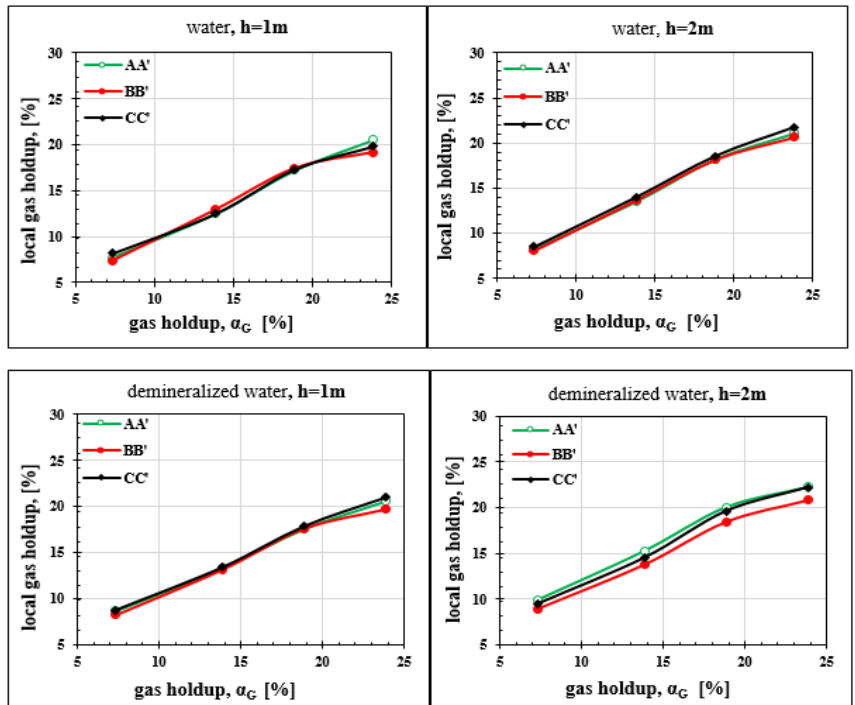
Figure 14. Relationship between local and global gas